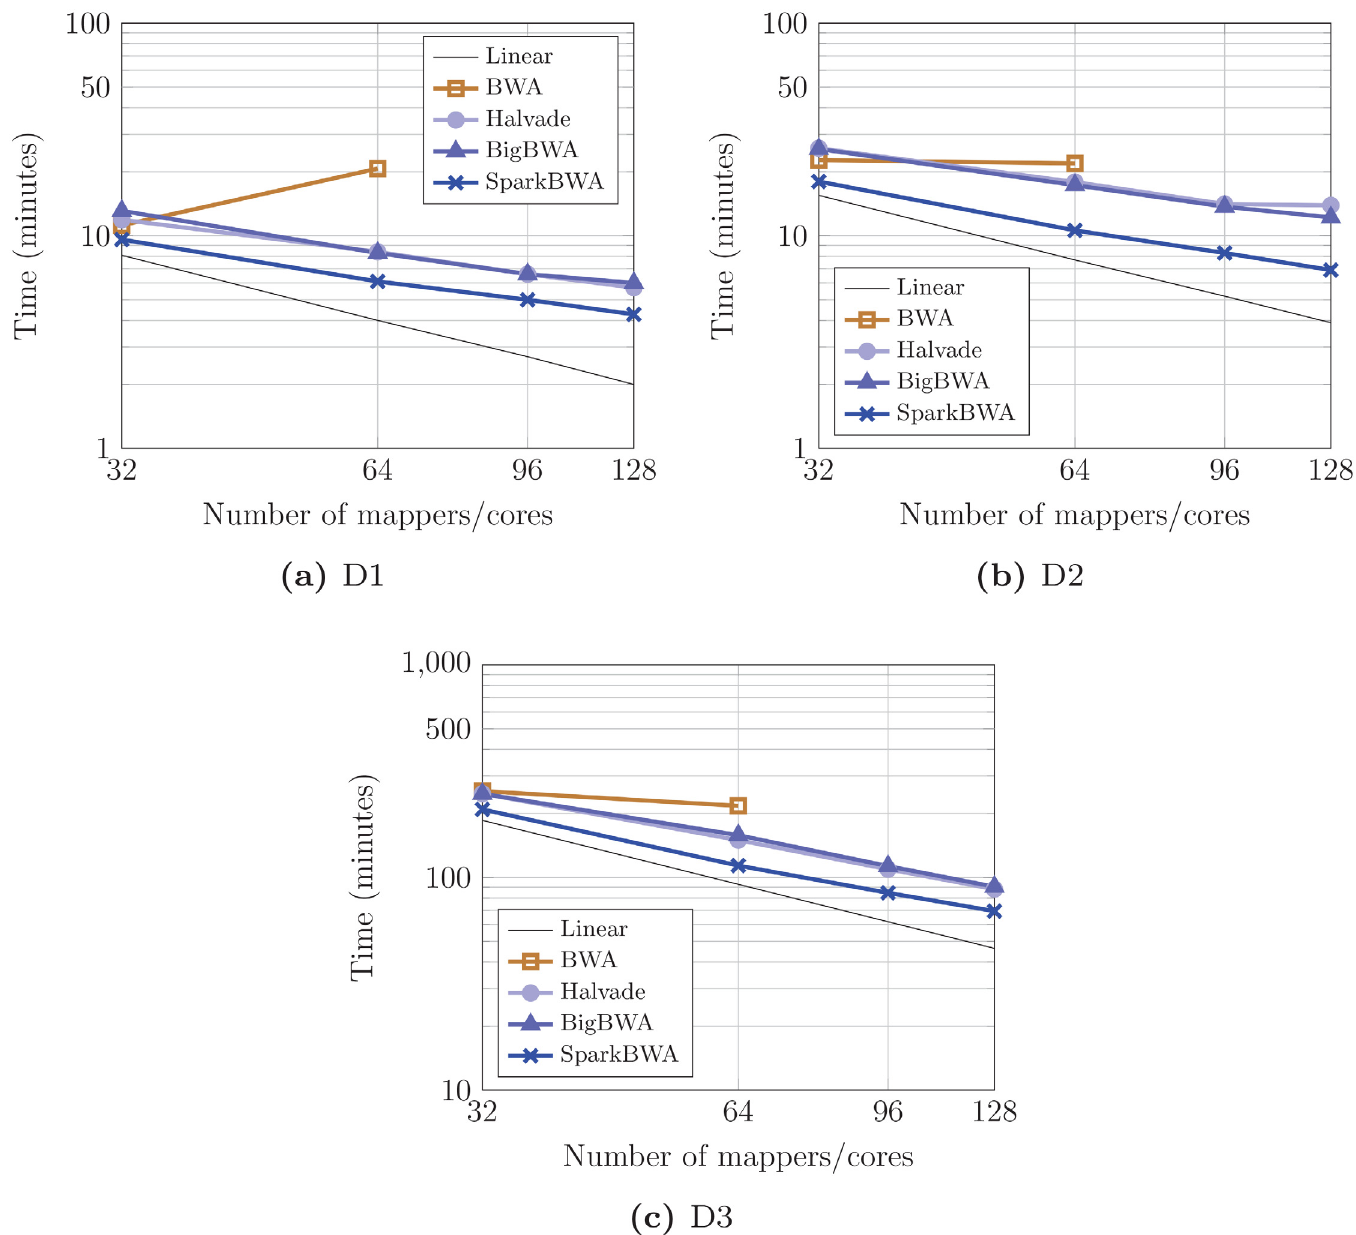
Fig 11. Execution times considering several BWA-based aligners running the BWA-MEM algorithm (axes are in log scale).